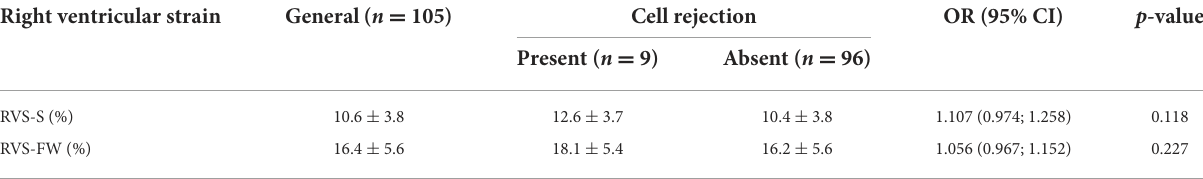
TABLE 11 Right ventricular strain, obtained by offline analysis of the three-dimensional full volume according to cellular rejection. Right ventricular